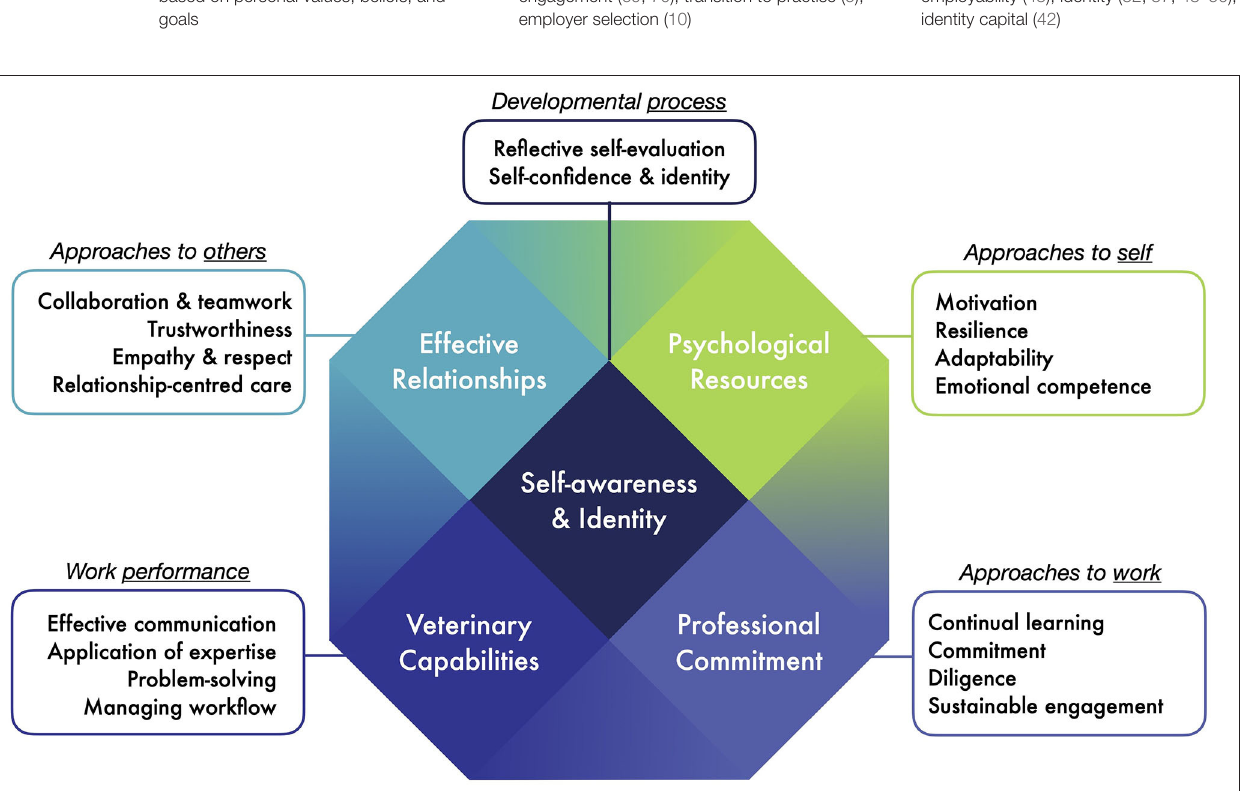
FIGURE 1 | The “crystal” model of veterinary employability, with five overlapping domains and 18 aligned capabilities.